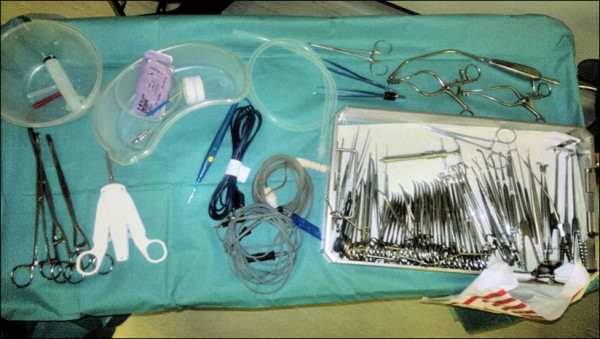
The instrument tray.